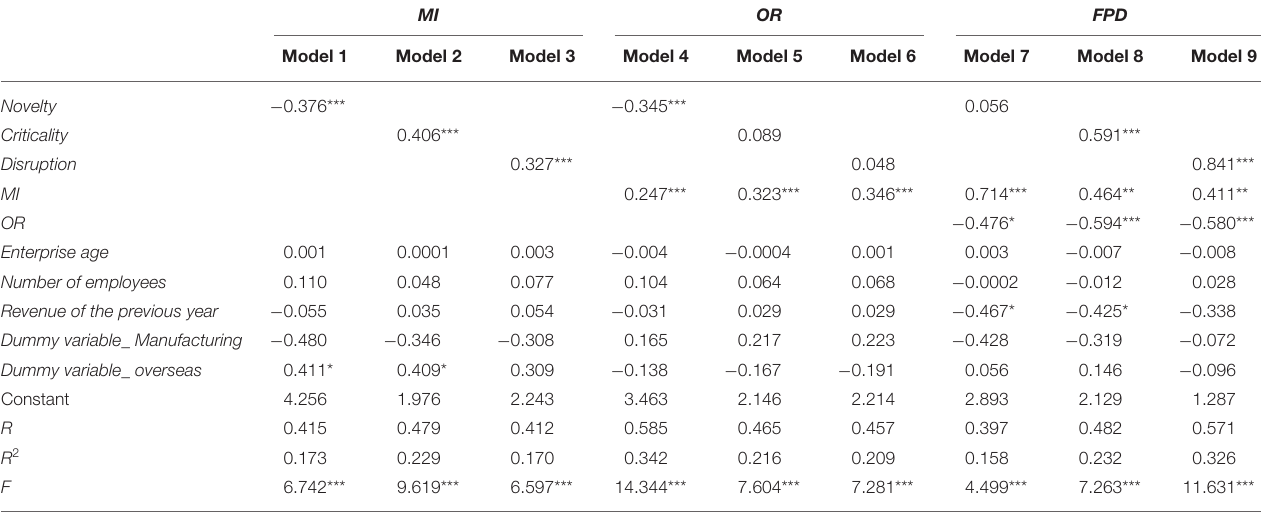
TABLE 5 | Results of hierarchical regression analyses ( N =